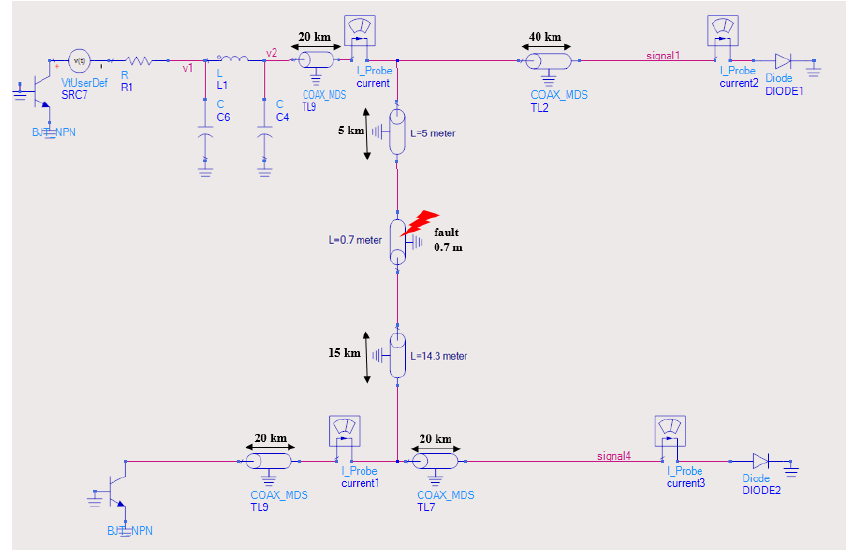
Figure 10. Equivalent circuit modeling of MTDC system: scenario